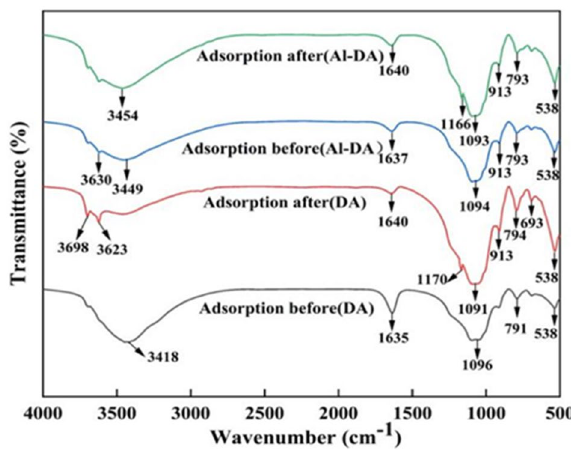
Figure 4. FTIR spectra of DA and Al-DA before and after adsorption.